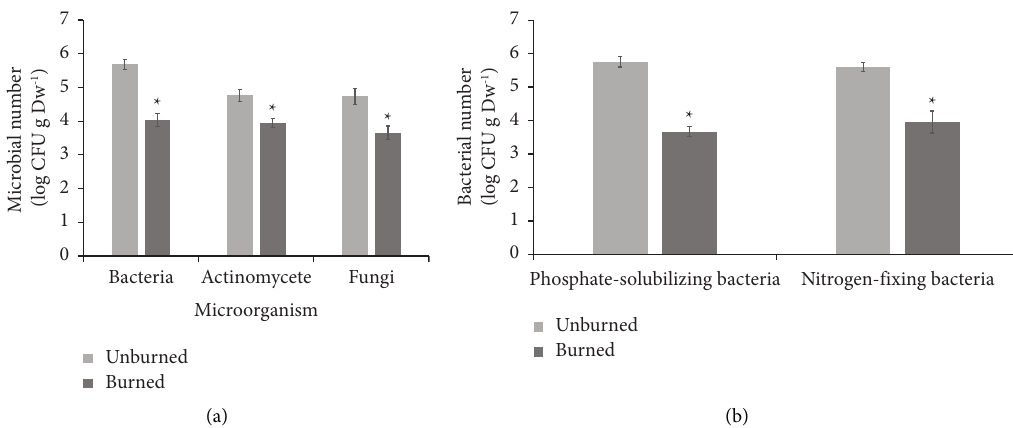
Figure 1: (a) Numbers of soil microorganisms and (b) numbers of nitrogen-fxing and phosphate-solubilizing bacteria in unburned and burned sugarcane plots. Te bar indicates ± standard error and ∗ � P < 0 . 05.